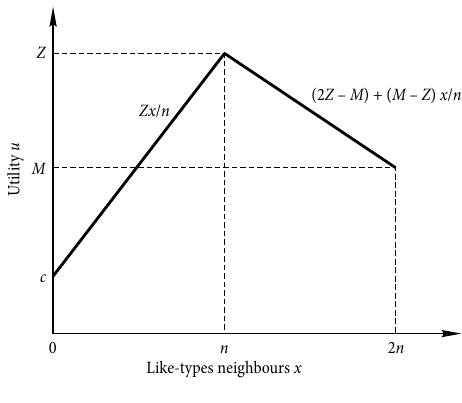
Fig. 2. Deterministic